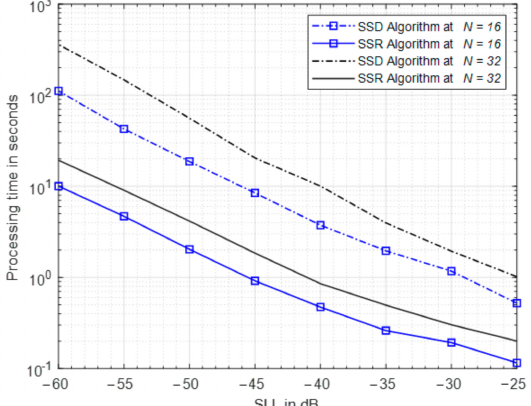
Figure 8. Processing time variation with the required SLL at different array sizes for the SSD and SSR algorithms.